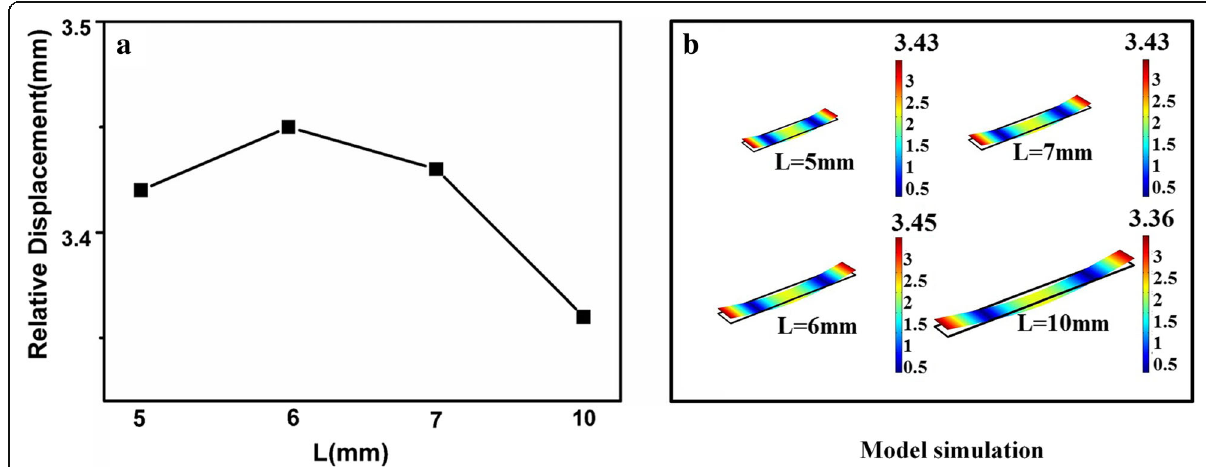
Fig. 1 Optimum length of the ME chip. a The relative displacement is different with the variation of length. b Simulation was used to optimize the length of the